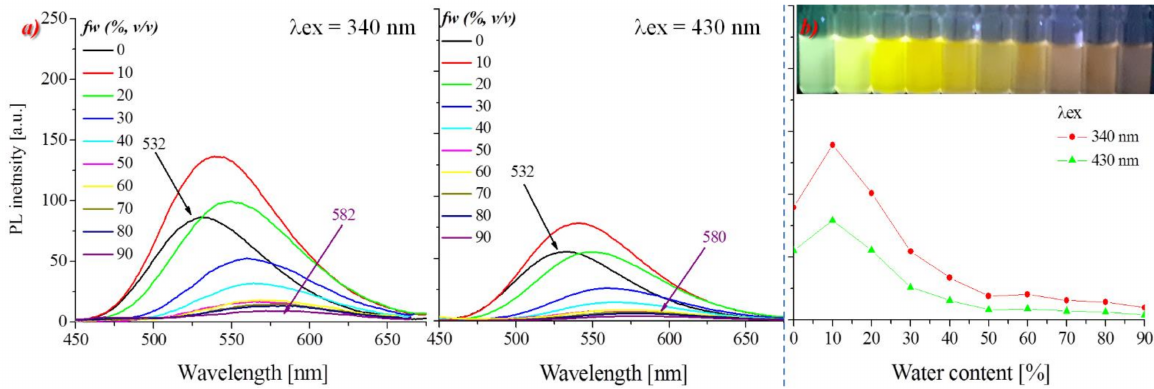
Figure 5. PL properties of AzNI-2 in a binary mixture of MeOH/H 2 O: ( a ) with an increasing water content ( fw ) at excitation of 340 and 430 nm; ( b ) λ em intensity vs. the water content ( fw ) in the solvents mixture. Photographs were taken under λ = 366 nm UV irradiation from a hand-held UV